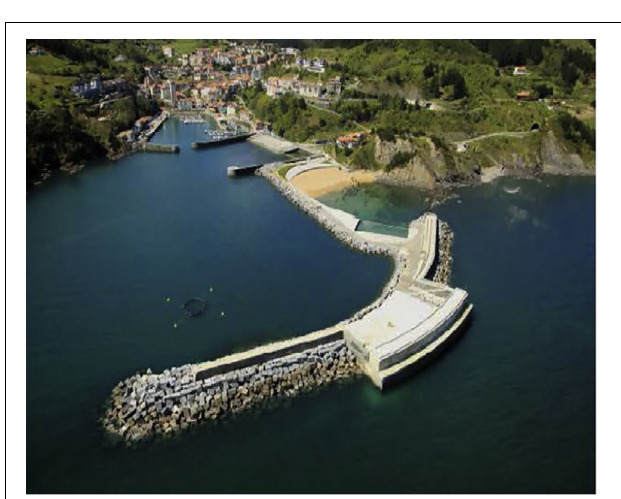
FIGURE 2 | OWC integrated into Mutriku breakwater (Pérez-Collazo et al.,